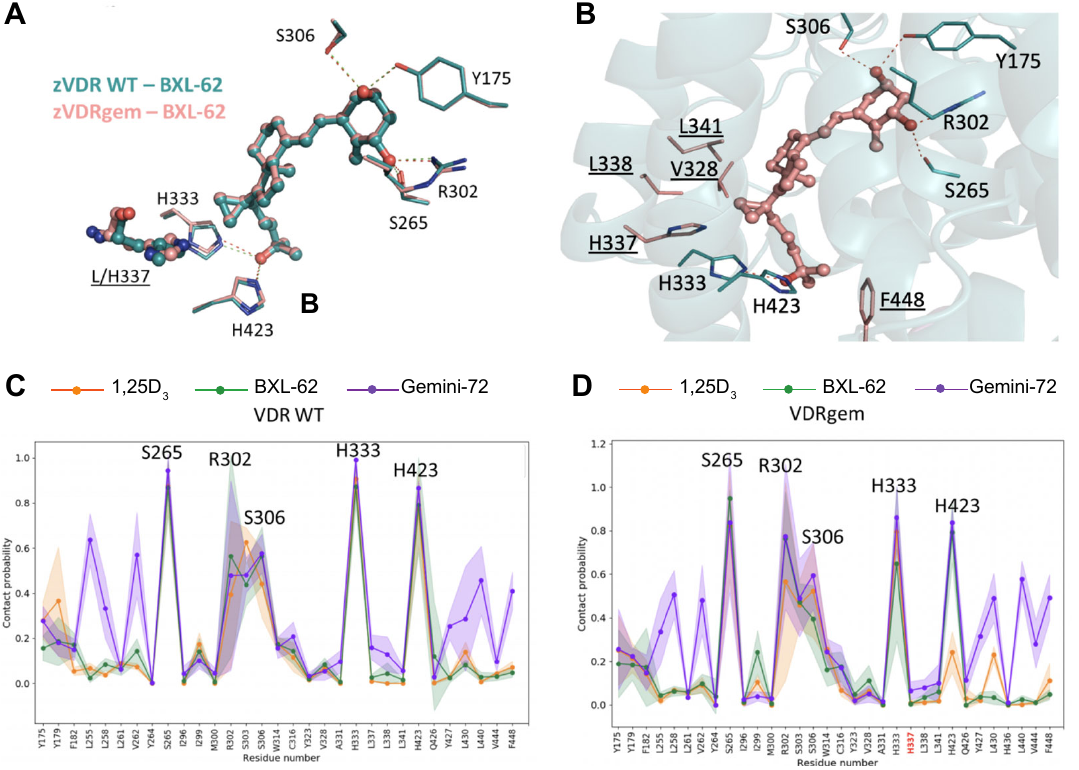
Figure 4. Crystal structure of zVDRgem—BXL-62, and dynamic network of ligand–amino acid contacts in VDR complexes. ( A ) Superposition of BXL-62 on the crystal structures of the zVDR WT (PDB 7BNS) and zVDRgem (PDB 7BNU) complexes; ( B ) Labeled zVDRgem residues correspond to those forming hydrogen bonds with BXL-62 (red) and those underlined correspond to residues that form stronger contacts with BXL-62 than with 1,25D 3 ; ( C , D ). Contact probabilities between 1,25D 3 (in orange), BXL-62 (in green) or Gemini-72 (in purple) and zVDR WT ( C ) and zVDRgem ( D ). Five independent 100 ns molecular dynamics (MD) simulations were computed and averaged, and the MD trajectories at the residue level interactions were analyzed with a distance threshold of 3.5